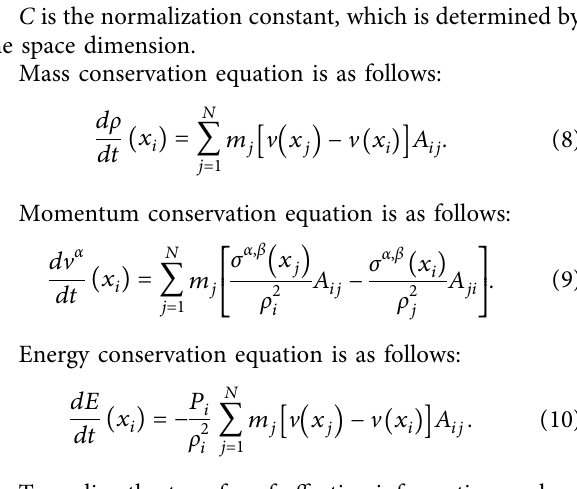
Figure 5: The numerical model used in the